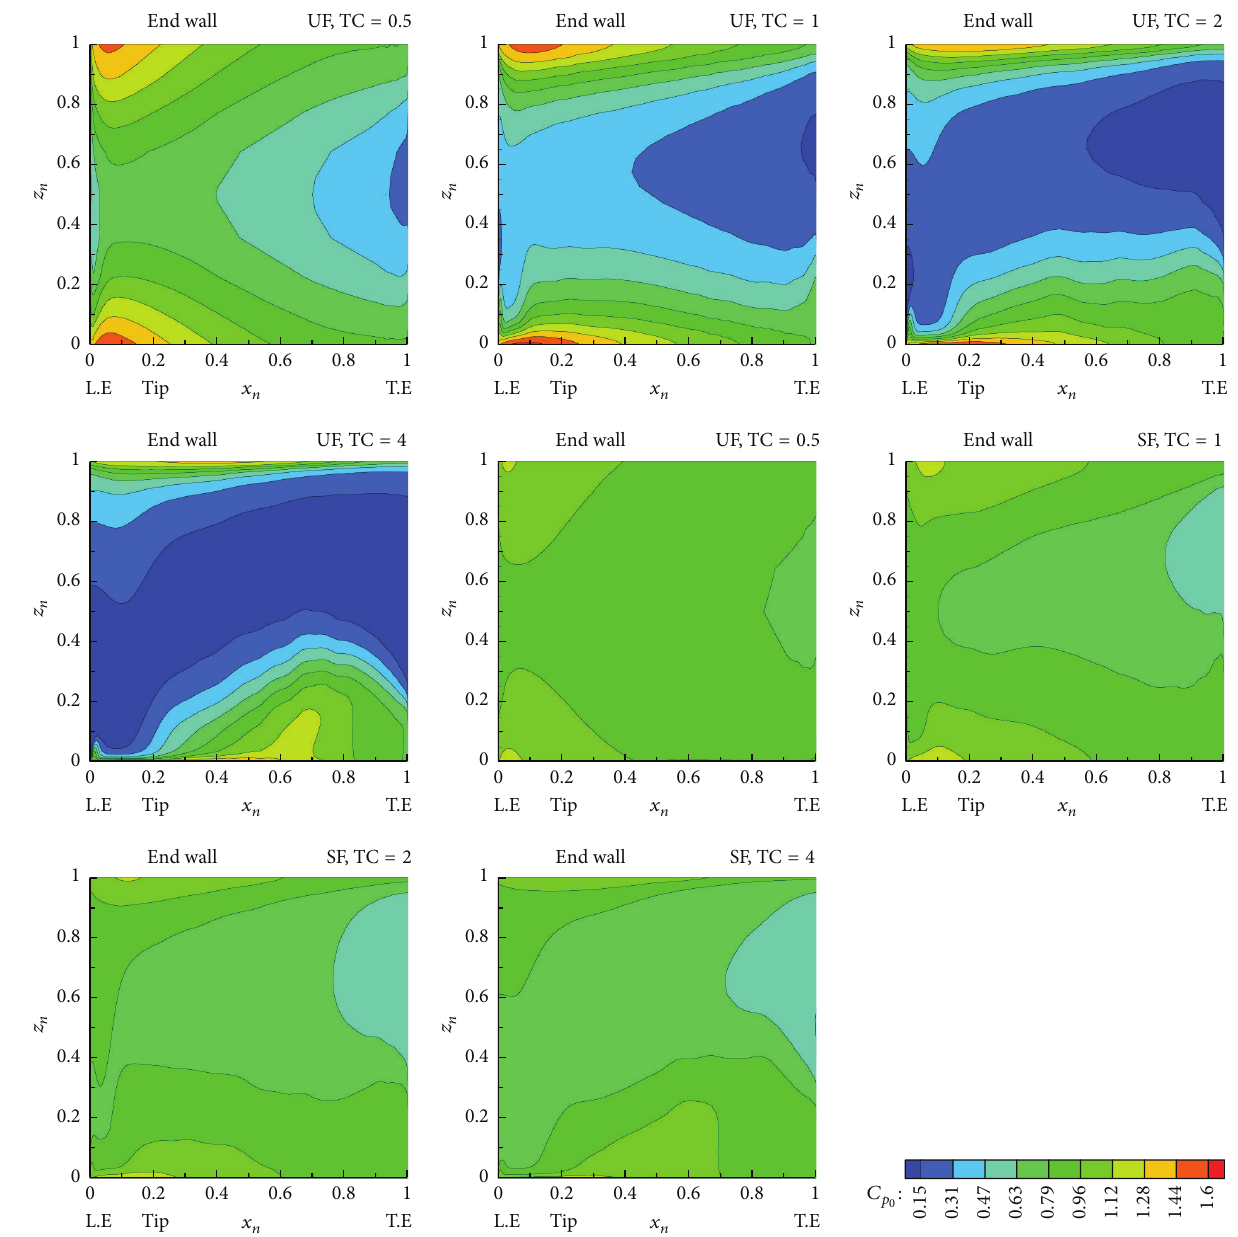
Figure 11: 𝐶 𝑝 contours on the suction side of tip gap region, with UF and SF for TC = 0.5 to 0